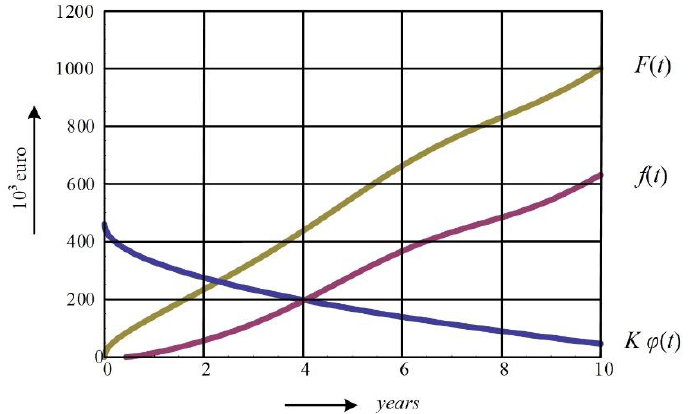
Figure 4. The function of cumulative maintenance costs f ( t ) and function of total costs of operating machine type 1.